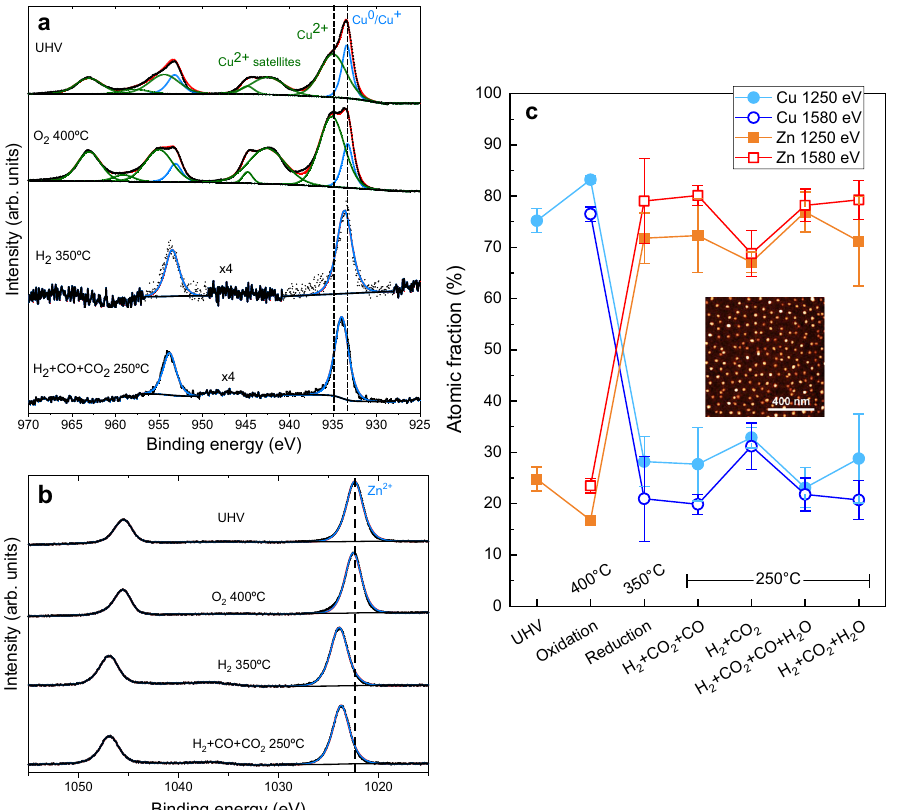
Fig. 4 Near-ambient pressure X-ray photoelectron spectra of CuZn NPs on SiO 2 /Si(100). a Cu 2p and b Zn 2p regions recorded using a photon energy of 1250 eV. c Copper and zinc atomic fractions obtained under different atmospheres as indicated on the plot. The two-photon energies used for probing the surface (1250 eV) and subsurface (1580 eV) regions of the CuZn NPs are displayed. Error bars correspond to the standard deviation. The inset shows an AFM image of the